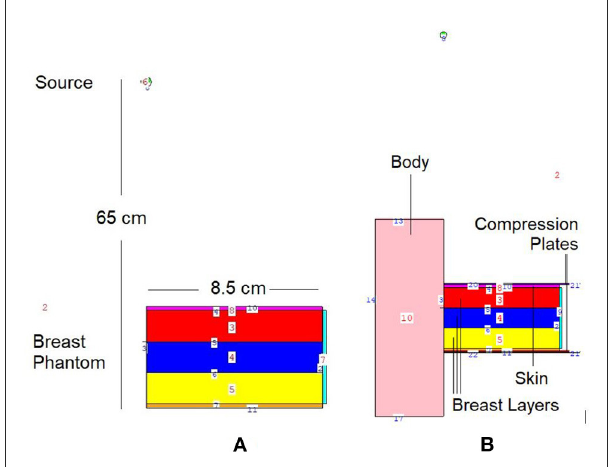
FIGURE1 2-D view of modeled MCNPX simulation setup from (A) breast phantom (B) breast phantom with body phantom and compression plates ( via MCNPX Visual Editor X22S).